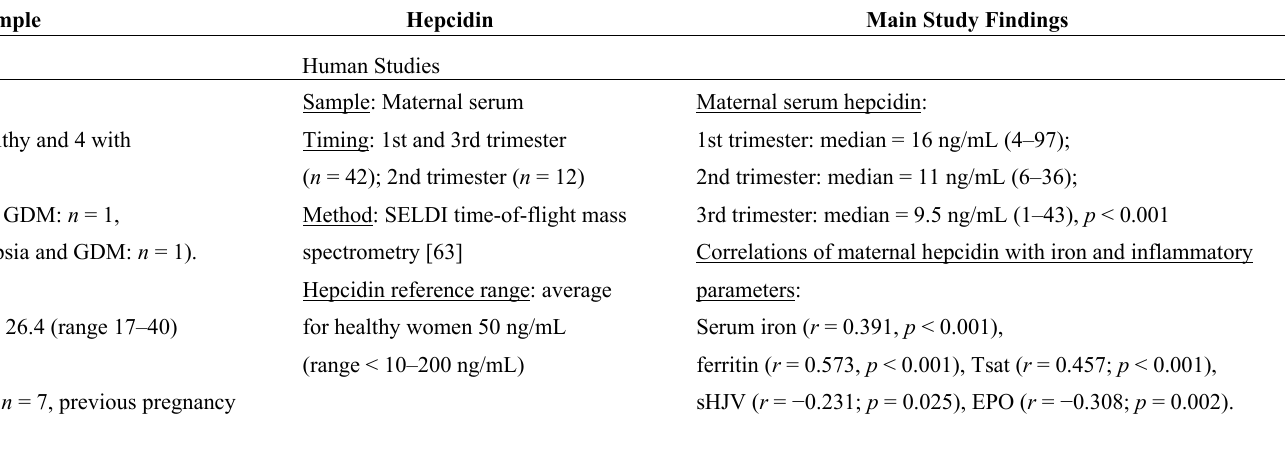
Table 1. Studies included in review of hepcidin values in